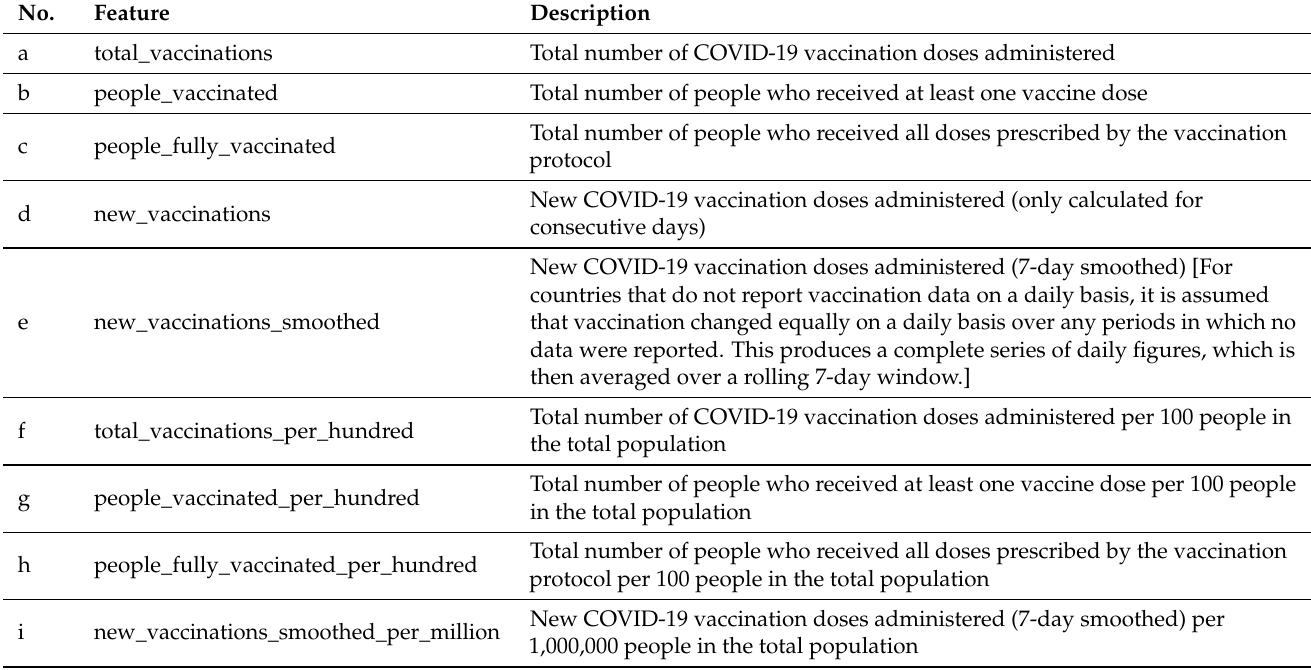
Table 4. Features related to COVID-19